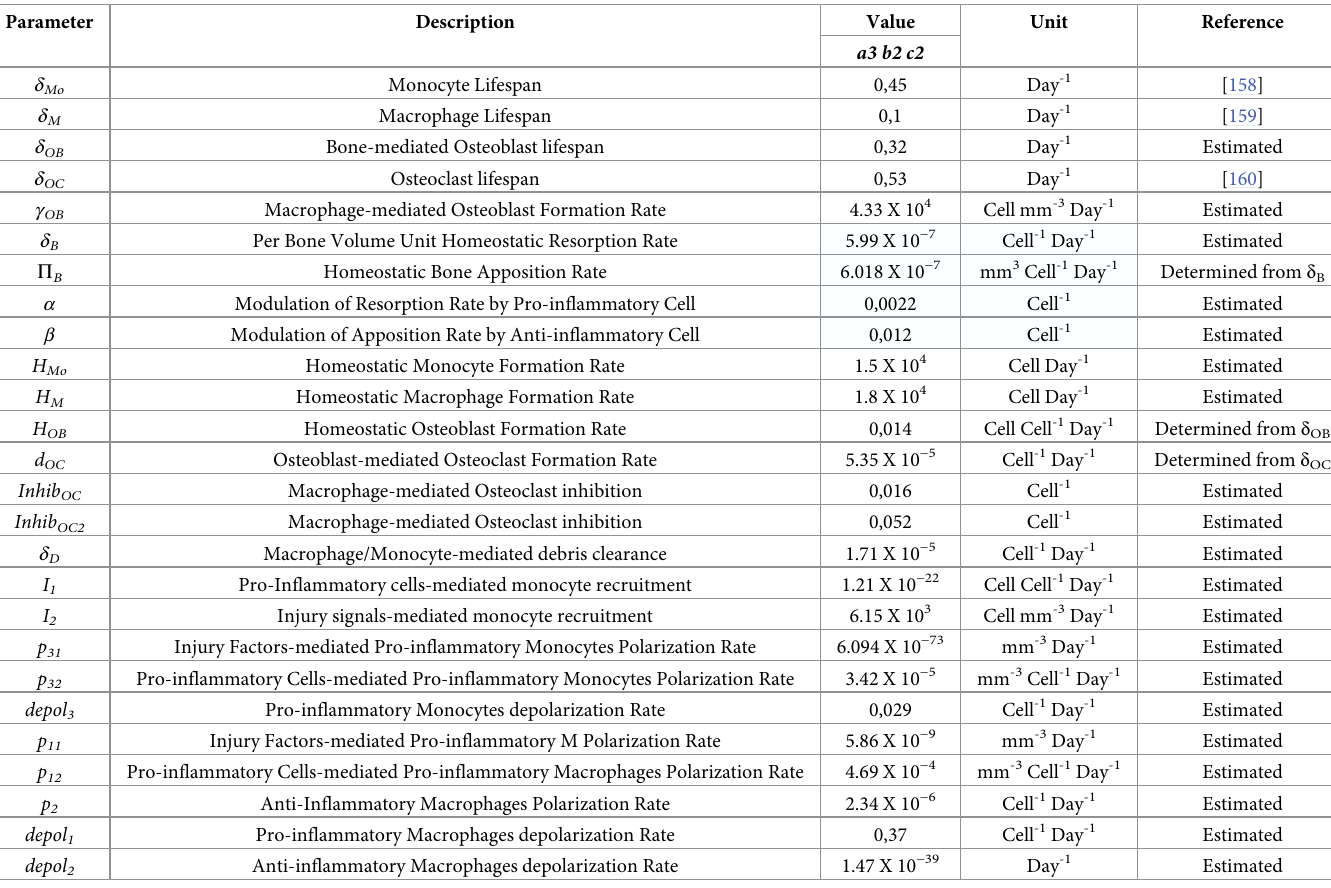
Table 4. Parameter values of the best fitting model a3b2c2. Table showing biological description of each mathematical variable with data-derived initial conditions and units. First column is the variable notation used in the equations for each parameter. Second column is the biological meaning of the variable. Third column is the initial condition for each variable, typically an initial cell population level. Fourth column is the variable